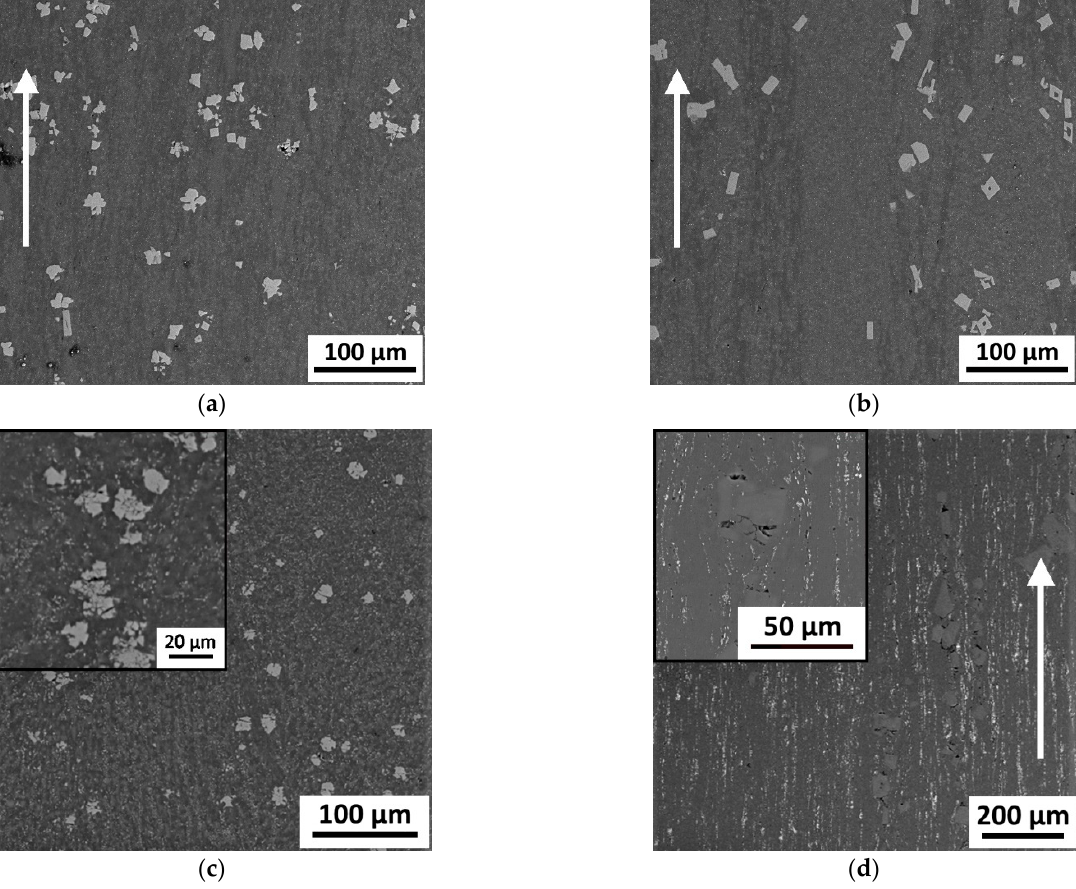
Figure 9. SEM images showing the microstructures of the hot-rolled sheets (arrows indicate the rolling direction): ( a )—Al- 6Ca-3Mn (longitudinal direction); ( b )—Al-8Ca-2Mn (longitudinal direction); ( c )—Al-8Ca-2Mn-1Ni (transversal direction); ( d )—FM180 (longitudinal direction).